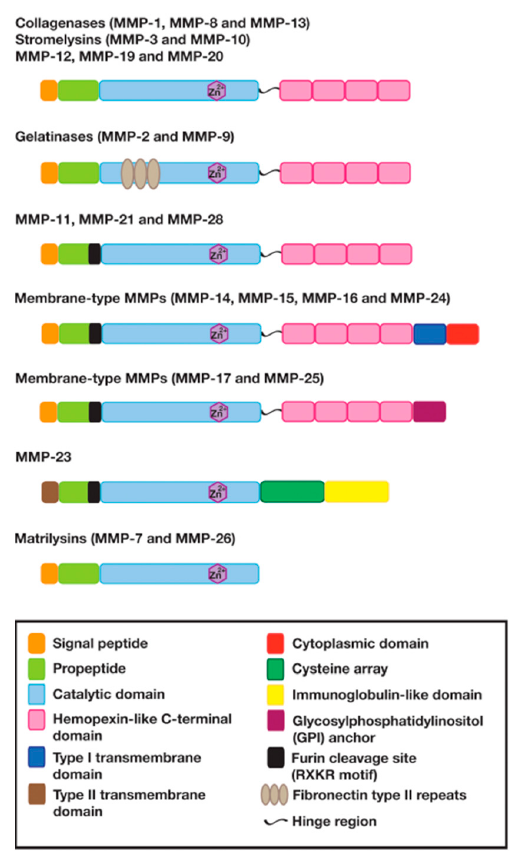
Figure 1. Matrix metalloproteinases (MMPs) are comprised of different subdomains. Most have a minimal domain (a signal peptide, propeptide, and catalytic domain), a hinge region, and a hemopexin-like C-terminal domain. Gelatinases (MMP-2 and MMP-9) contain three repeats of a fibronectin type II motif in the catalytic domain. Membrane-type MMPs have a type I transmembrane domain/cytoplasmic domain or a glycosylphosphatidylinositol (GPI) anchor in addition. MMP-23 contains a type II transmembrane domain, a cysteine array, and an immunoglobulin-like domain. The propeptide contains a furin cleavage site (RXKR motif) in MMP-11, MMP-21, MMP-23, MMP-28, and membrane-type MMPs. MMP-7 and MMP-26 lack both a hinge region and a hemopexin-like C-terminal